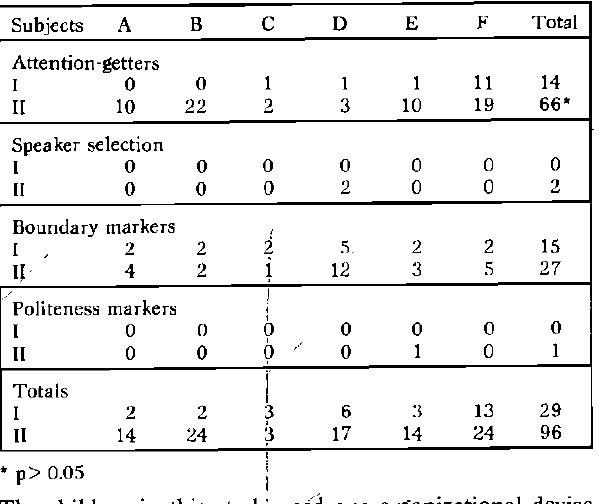
Table 5: Variation within Organizational Devices for all subjects in Interactions I and II